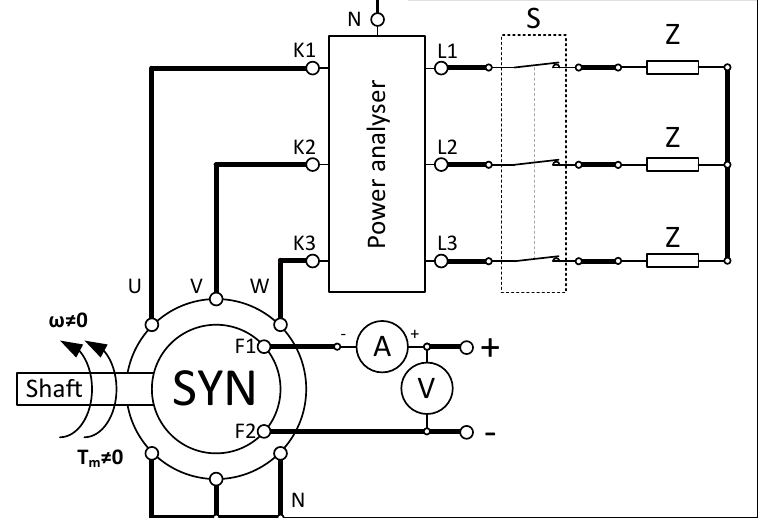
Figure 5. Diagram of measurement setup for synchronous generator resistive and inductive on-load transient